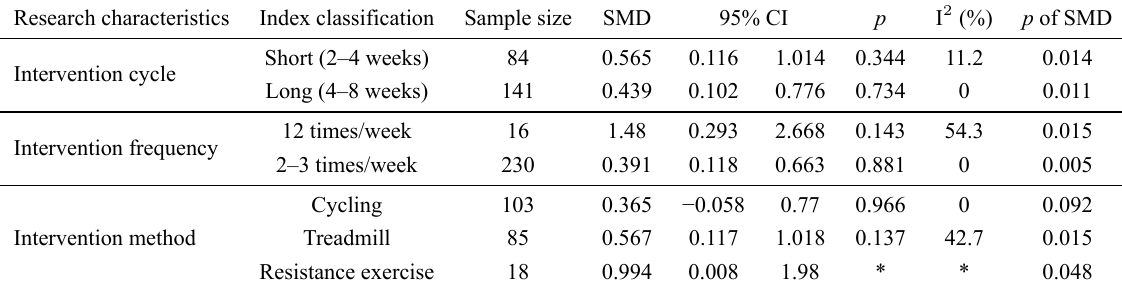
Table 2. Table showing the subgroup analysis characteristics.